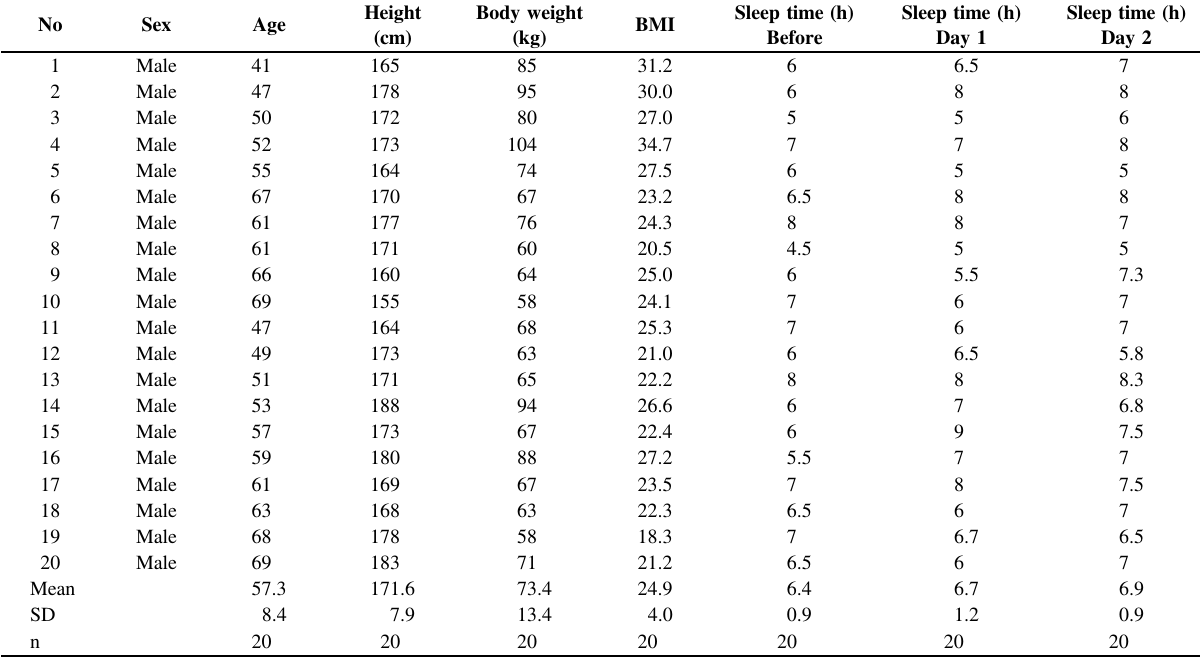
Table 1 Information of the